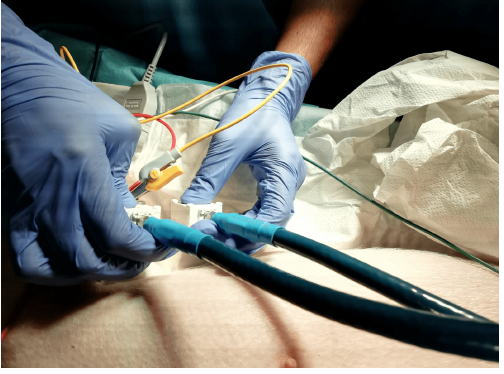
Figure 10. In vivo measurement.